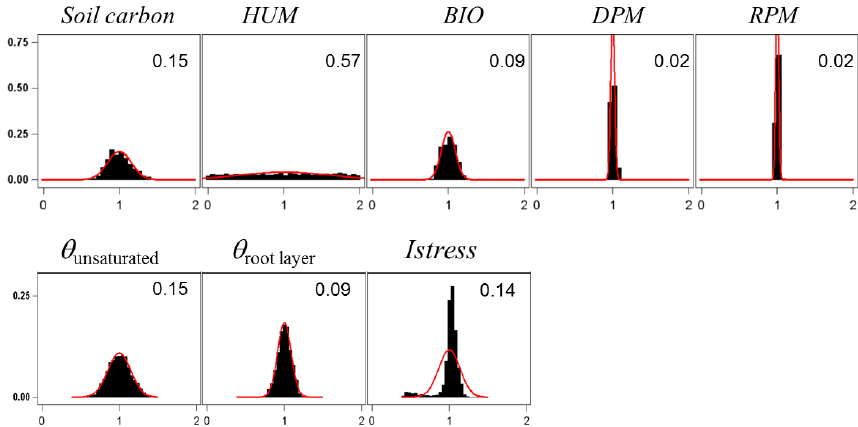
Figure 12. Normalized uncertainty in the main soil variables simulated by the GO+ model. Each graph shows the distribution of variable values generated from 14 parameter distributions (Table 3). The red curve is the normal distribution fitted and the numbers inset is the standard deviation. The variable abbreviations are explained in Table